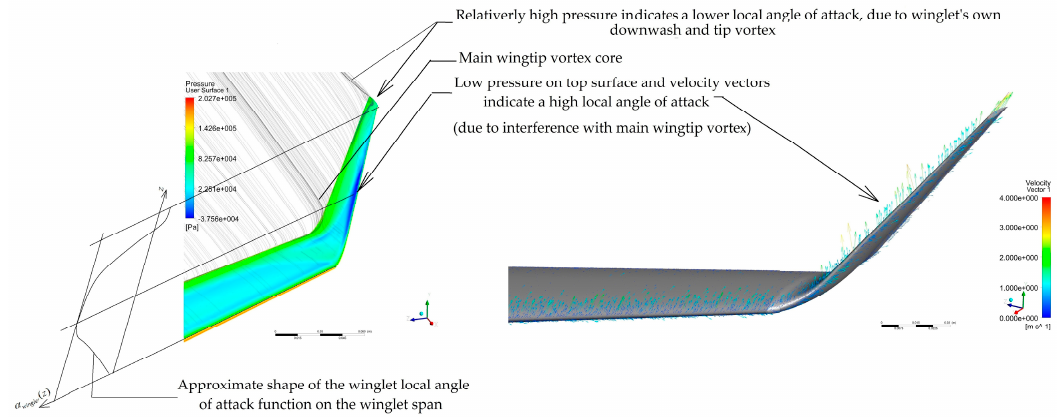
Figure 11. Three-dimensional flow field over a non-twisted, half canted winglet with ψ = π /4 and its local angle of attack approximate dependency on the winglet span location. CFD results shown at M = 0.8, α = 2°.